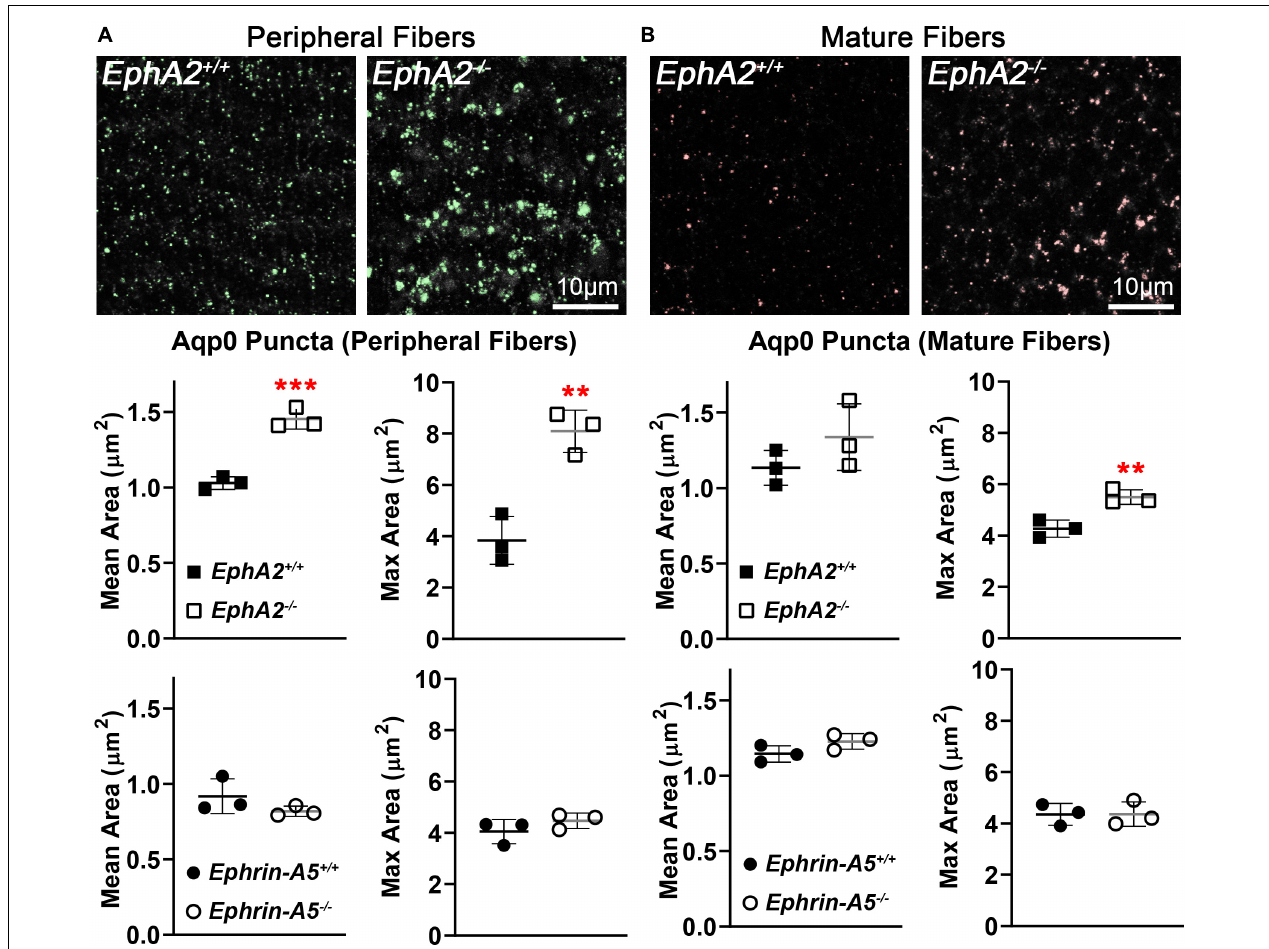
FIGURE 4 | Quantification of Aqp0 puncta in peripheral and mature fiber cells from cross sections of control, EphA2 − / − and ephrin-A5 − / − lenses. (A) In control peripheral lens fibers, there are relatively small Aqp0 puncta, while in EphA2 − / − cells, there are much larger Aqp0 puncta/aggregates (highlighted in green). Quantification from three staining samples shows small Aqp0 puncta (mean and max puncta area, µ m 2 ) in EphA2 + / + , ephrin-A5 + / + and ephrin-A5 − / − peripheral lens fibers. In contrast, Aqp0 puncta/aggregates are significantly larger (mean and max area) in EphA2 − / − peripheral lens fibers. (B) In mature EphA2 − / − lens fibers, larger Aqp0 puncta/aggregates are observed (highlighted in red). Quantification shows increased Aqp0 max puncta area in EphA2 − / − mature fibers. There are no changes in Aqp0 puncta found in ephrin-A5 − / − mature lens fibers. Scale bars, 10 µ m. **, p < 0.01 and ***, p < 0.001.